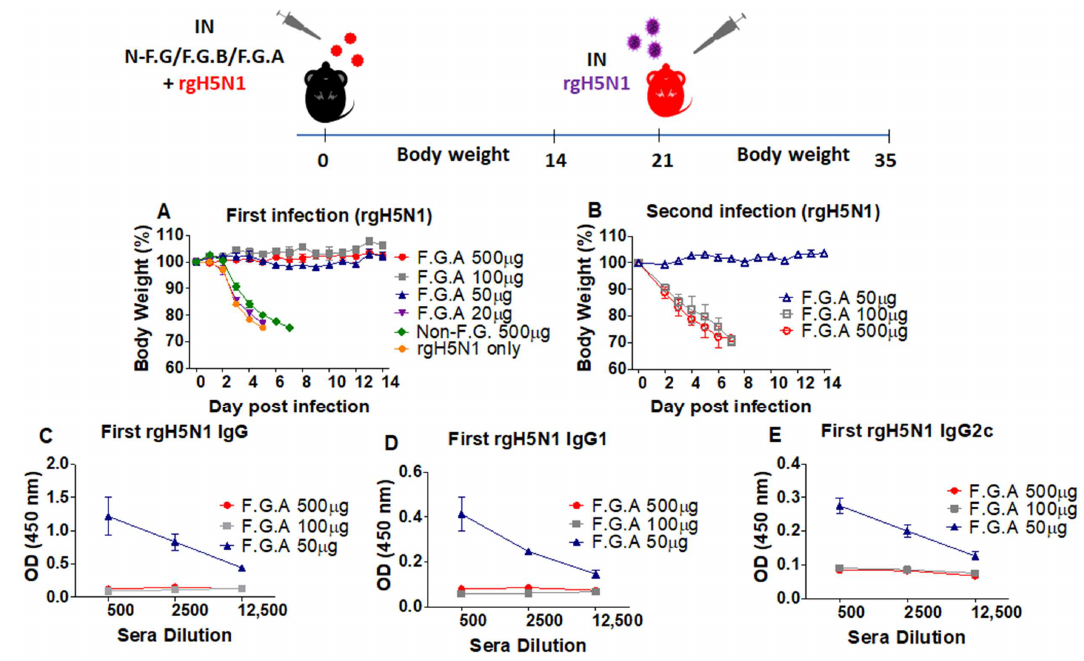
Figure 2. Low dose of fermented ginseng extract sample A provided protection against rgH5N1 influenza virus during primary and secondary infection. Groups of mice ( n = 5, wild-type C57BL/6) mice were intranasally (IN) infected with a mixture of 10 LD 50 of A/Vietnam/1203/2004 (rgH5N1) virus and fermented ginseng sample A or B at different doses (20, 50, 100, 500 µ g). After 14 days of body weight monitoring, the serum sample was collected to detect the levels of IgG and IgG isotypes using an ELISA method. The mice that survived from the first infection were challenged again with rgH5N1 (10 LD 50 ). ( A ) Body weight change after the first infection (10 LD 50 , rgH5N1) and ( B ) body weight change after the second infection (15 LD 50 , rgH5N1). ( C ) rgH5N1-specific IgG, ( D ) IgG1, and ( E ) IgG2c after the first infection. F.B.A: rgH5N1 virus + fermented ginseng sample A; F.G.B: H5N1 virus + fermented ginseng sample B; rgH5N1 only: virus infection without ginseng samples.